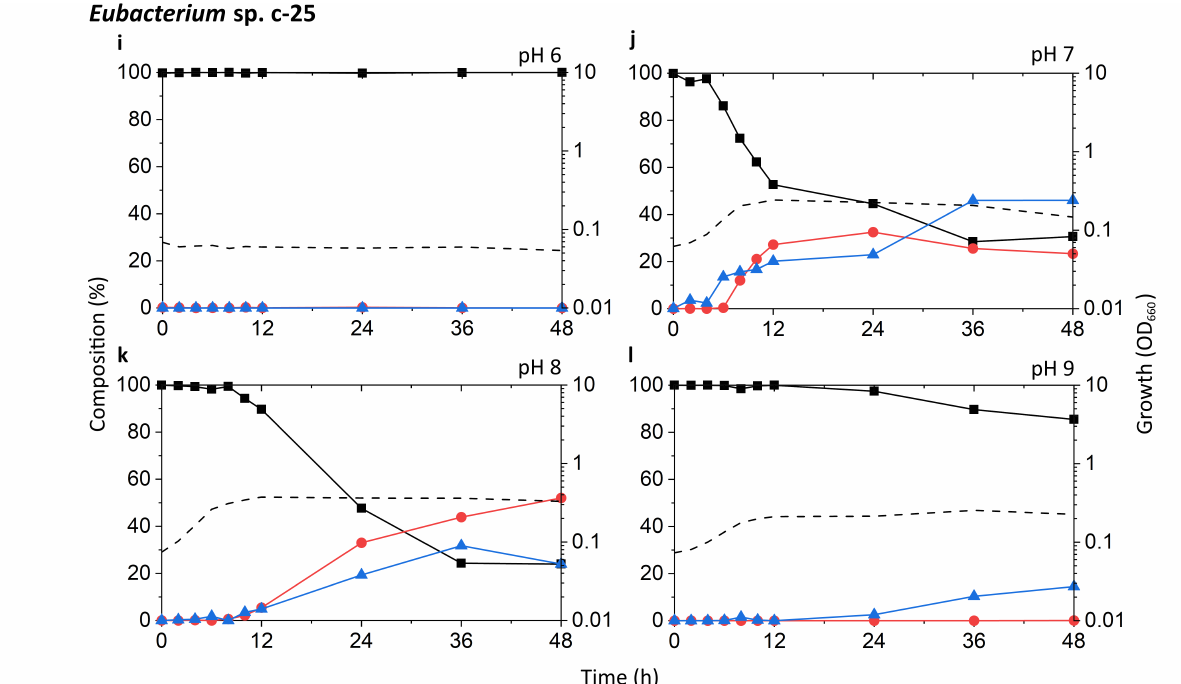
Figure 3. Time-course analysis of the growth and bile acid profile of DCA producers including Eubacterium sp. c-25 under different initial pH conditions. Tested strains are: ( a – d ) C. scindens ATCC 35704 T , ( e – h ) C. scindens G10, and ( i – l ) Eubacterium sp. c-25. Growth was measured by OD 660 (dotted line). The percent composition is calculated by the concentration of a given bile acid relative to the summed concentration of CA (black square), DCA (red circle), and 7-oxo-DCA (blue triangle). The average values of three independent experiments are